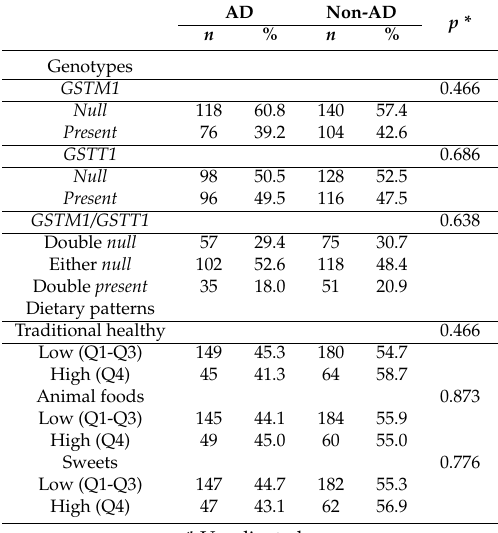
Table 6. Association between dietary pattern and atopic dermatitis (AD) by of the glutathione S-transferase M1 ( GSTM1 ) and /or T1 ( GSTT1 ) genotypes ( n = 438) *.